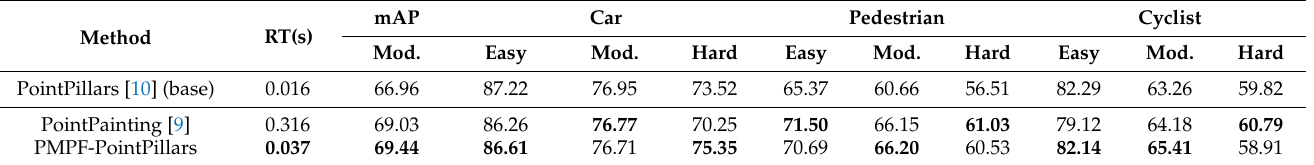
Table 2. Comparison with PointPainting in KITTI 3D detection validation set. The PMPF method shows an overall improvement in car and cyclist categories, a 0.41% improvement in mAP compared to PointPainting and, more importantly, a great improvement in run time